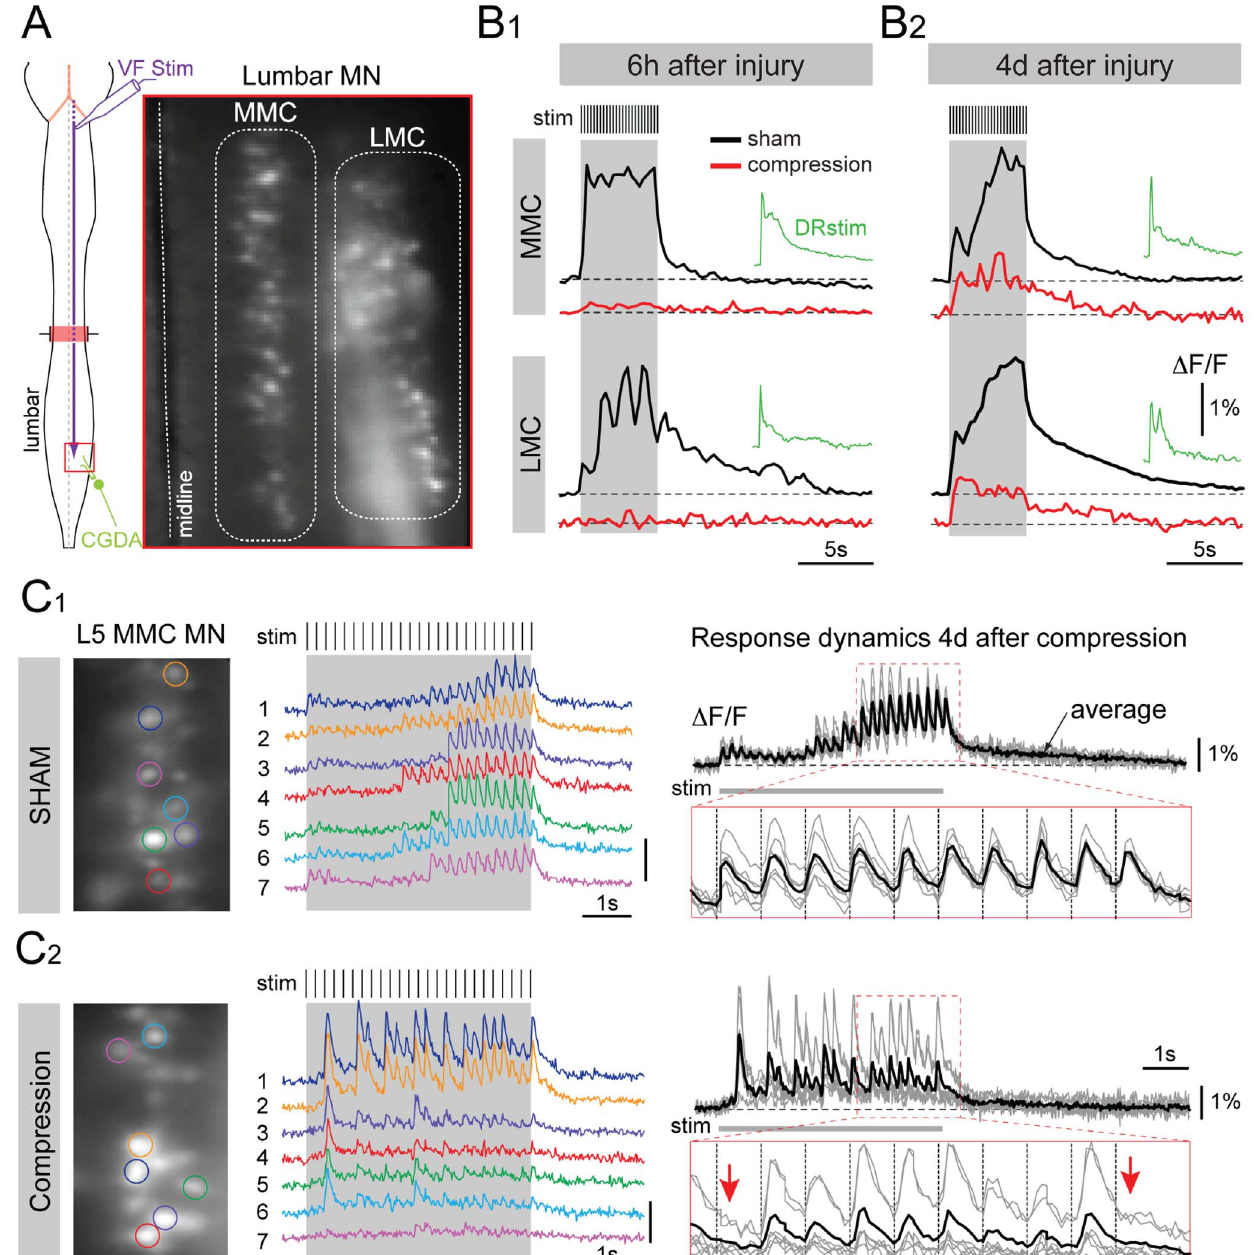
Figure 7. Recovery of responses to general bulbospinal pathway stimulation following SCC, assessed with optical recording. (A) Schematic of the ex vivo preparation of the brain stem and spinal cord showing the site of bulbospinal pathway stimulation in the ventral funiculus (VF Stim) and the CGDA labeling of the L5 ventral root, and a photograph of the CGDA labeled lumbar MNs in the medial motor column (MMC) and lateral motor column (LMC). (B) Low temporal resolution (4 Hz frame rate) optical recordings of calcium transients elicited in MMC and LMC MNs in response to VF stimulation (same parameters as in Fig. 6) 6 h and 4 days after surgery/injury in sham control mice (B1 and B2, black traces) and SCC mice (B1 and B2, red traces). Green traces show responses to stimulation of the L5 dorsal root in SCC. D F/F represents fluorescence change in % relative to baseline. (C) High temporal resolution (50 Hz frame rate) recordings from individual L5 MMC MNs in response to VF stimulation in sham control (C1) and SCC (C2) mice 4 days after surgery/injury. Each colored trace shows the calcium transients in one of the individual MNs outlined by a colored region of interest in the photographic images to the left. Black and grey traces (right column) represent the superimposed individual traces (grey) and the averaged response (black) from the same MNs, with the expanded traces (outlined in red) showing the responses to the last 10 pulses of the train. Red arrows in the expanded trace of C2 (4 days post-injury) indicate absent calcium transients in response to the 15th and the last pulses of the train.